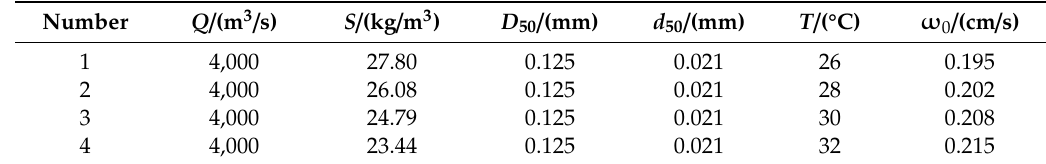
Table 5. Computational